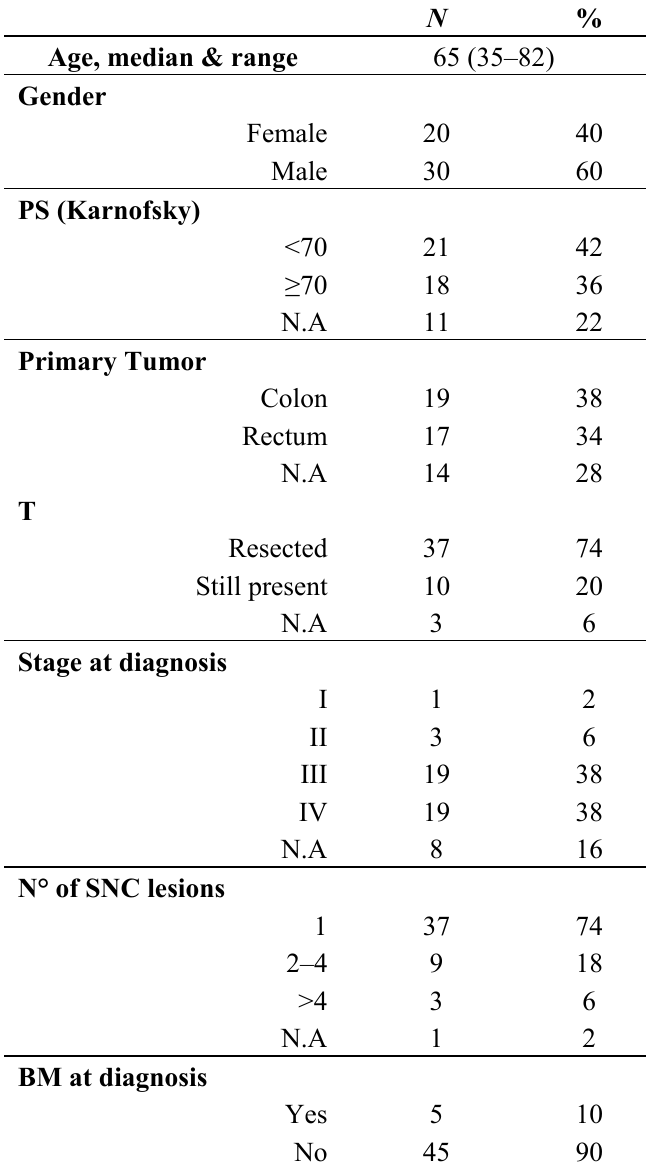
Table 1. Demographics and clinical characteristics of the enrolled patients ( n =